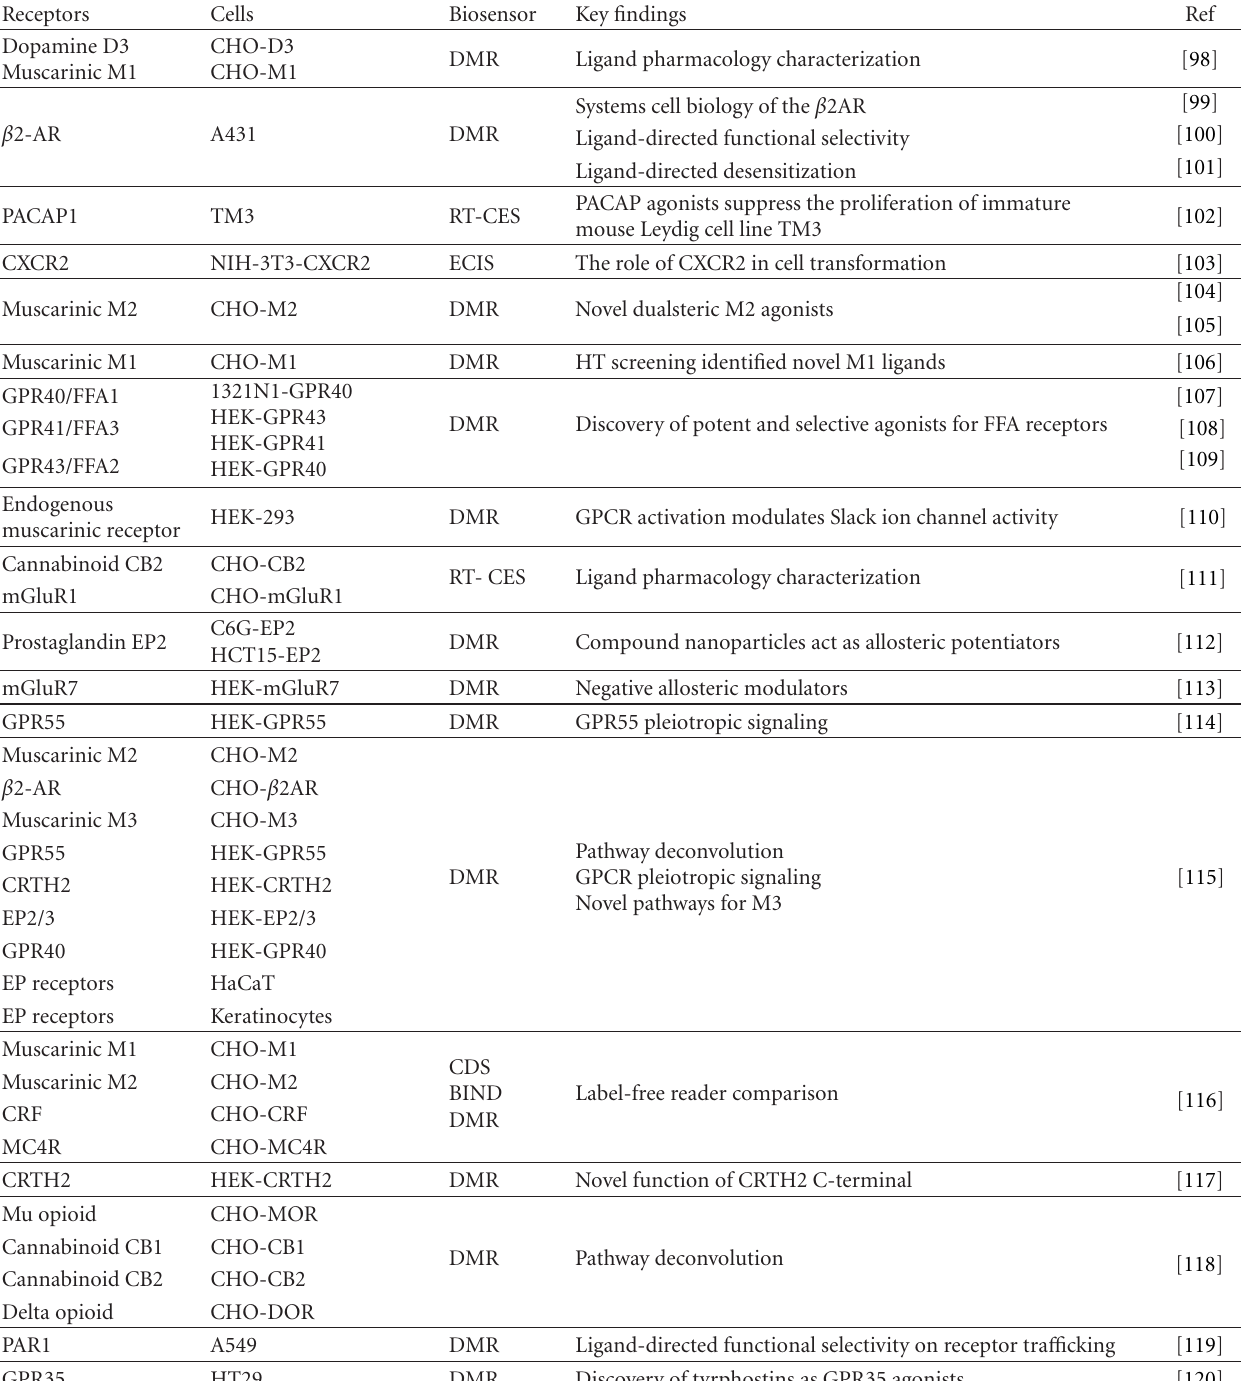
Table 2: Receptors, cell lines, and technologies and key points of the studies related to the use of label-free cellular assays for GPCRs.